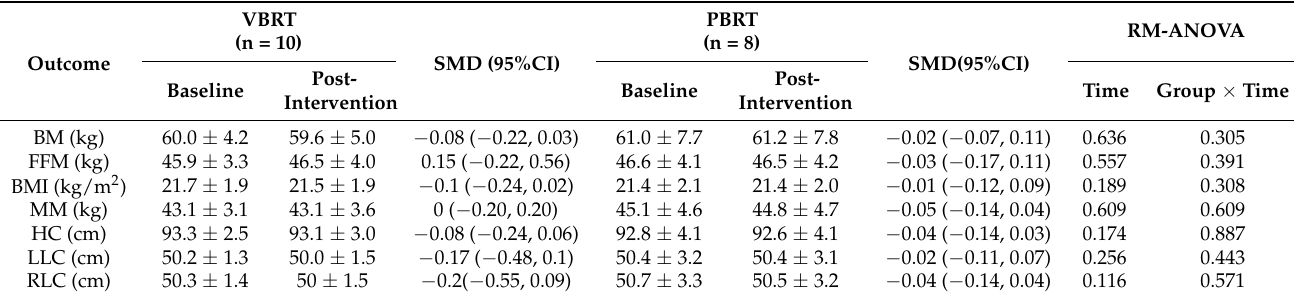
Table 2. Results of lower limb muscle mass and morphological